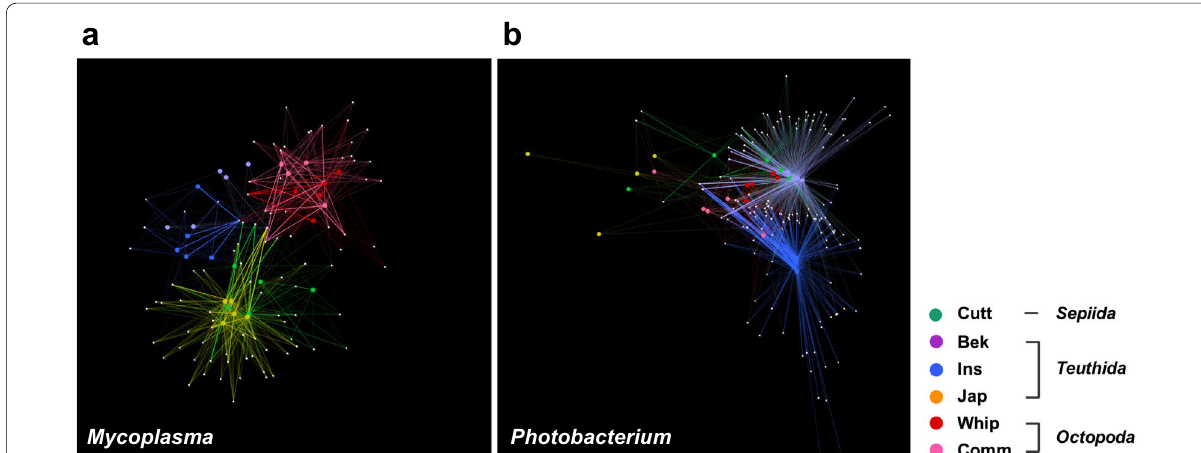
Fig. 4 Network analyses of two core genera in cephalopod species, constructed by an unsupervised oligotyping approach. The networks of oligotypes belonging to a Mycoplasma and b Photobacterium were plotted. The edges connecting nodes representing cephalopod samples (large circles) to identified oligotypes in a particular sample are colored according to the host species (edge‑weighted spring embedded model in Cytoscape v. 3.4.0). Abbreviations: Cutt, cuttlefish; Bek, beka squid; Ins, Inshore squid; Jap, Japanese flying squid; Whip, whiparm squid; Comm, common octopus